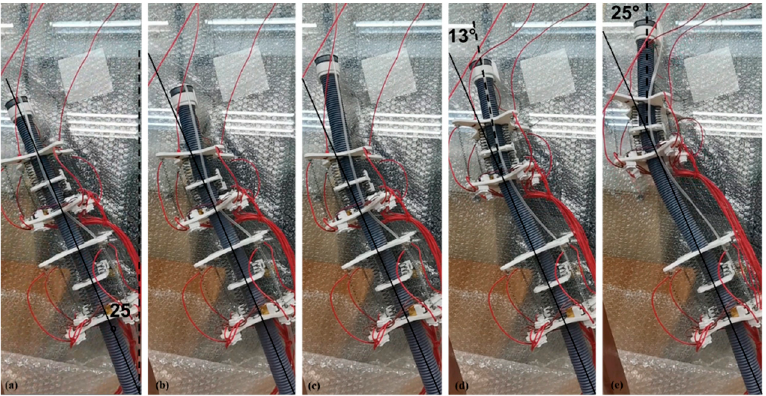
Figure 17. Two-module prototype used for tilt correction. ( a – e ) represents the motion of the robot.